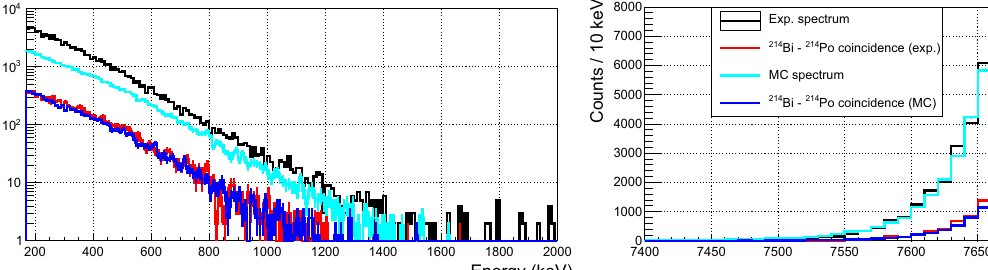
Fig. 1 Experimental data (black) and MC simulations (cyan) referring to the measurement of the copper plate contaminated with the 222 Rn daughters belonging to the 238 U chain. In the left pad we show the lower energy range where we searched for 214 Bi β -events in time coin- cidence with 214 Po α -events (right pad). The MC spectrum, comprised of 214 Bi and 214 Po events only, is normalized at the 214 Po α peak and, as